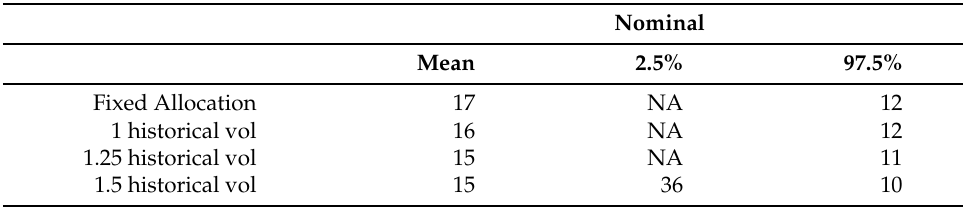
Table 14. Break Even Years at Different Fixed Target